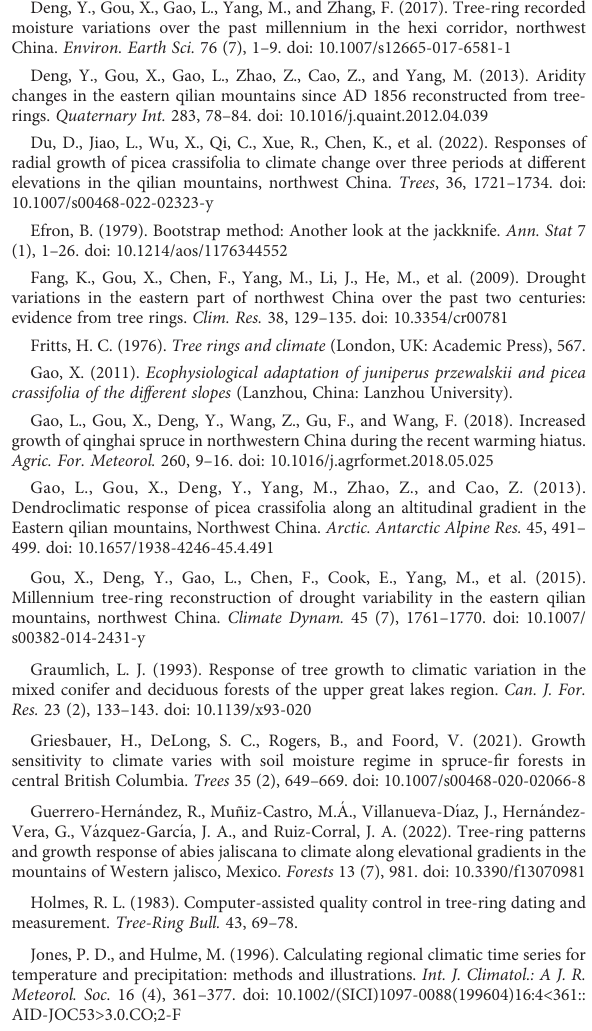
SUPPLEMENTARY TABLE 1 Statistical information of sampling sites.